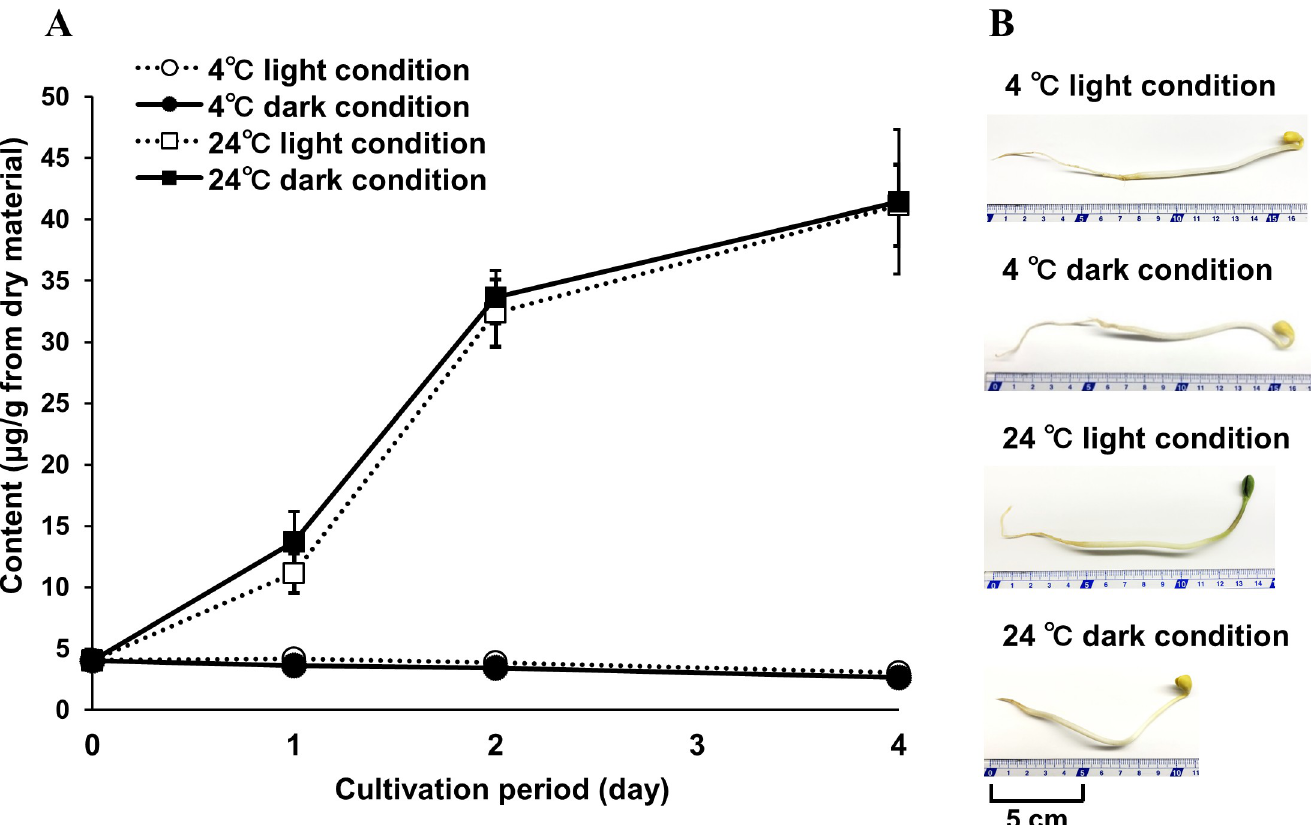
Fig 5. CM contents of soybean sprout hypocotyls grown under different light (light and dark) and temperature (4˚C and 24˚C) conditions (A), and soybean sprouts cultivated under each condition for 2 days (B). Sample details and CM contents are shown in Table 2. The data were analyzed by ANOVA followed by Tukey’s test, and p < 0.001 was considered statistically significant. There were no significant differences in CM content between the light and dark groups at 4˚C or at 24˚C. However, CM contents were significantly higher in the 24˚C samples than in the 4˚C samples in all cases (i.e., 4˚C light versus 24˚C dark, 4˚C light versus 24˚C light, and so